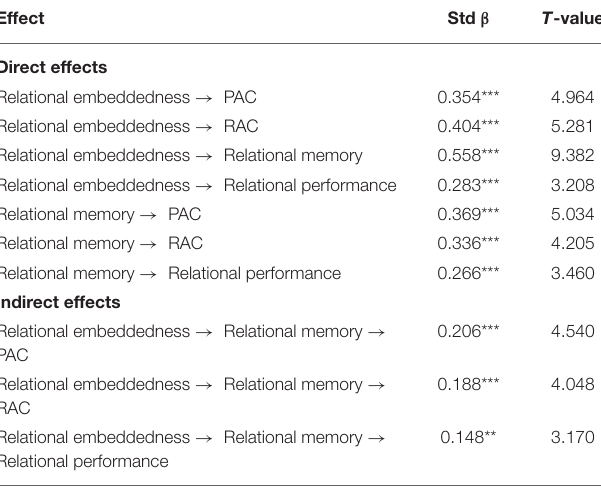
TABLE 3 | Structural model assessment for direct and indirect